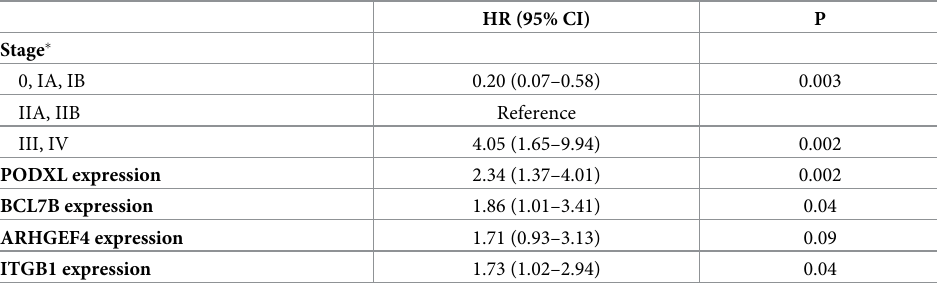
Table 5. Multivariate analysis using a backwards and a forwards selection procedure.